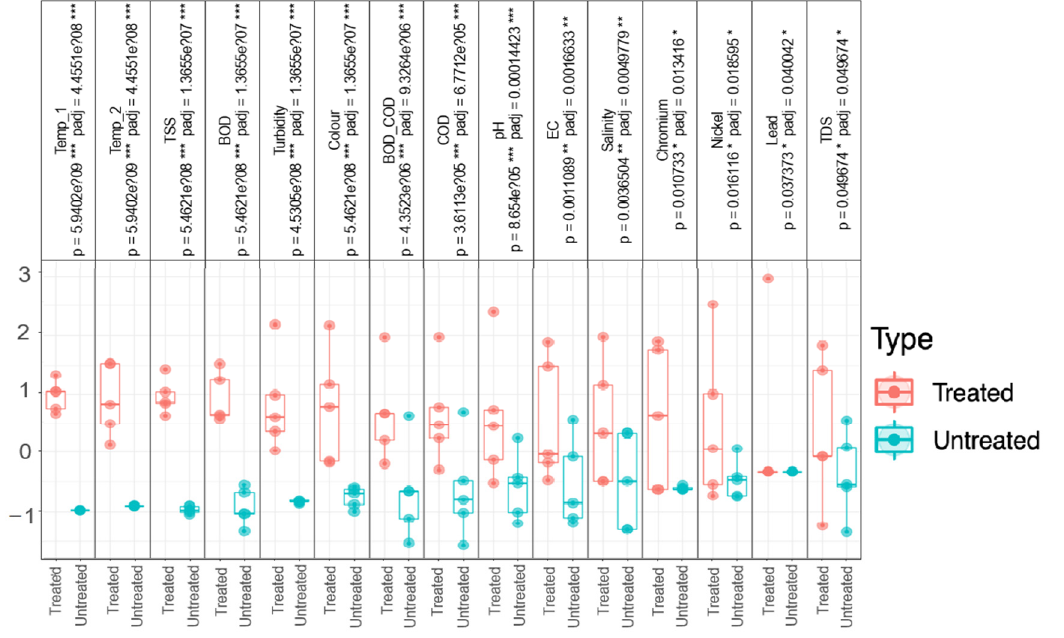
Figure 1. Box-plot graph showing the results of a Kruskal–Wallis statistical test to determine which of the water quality parameters (TSS, BOD, Turbidity, Colour, BOD_COD, COD, pH, EC, Salinity, Chromium, Nickel, Lead, TDS) were discriminating between the Untreated wastewater (in blue) and the Treated biotreated hospital wastewater (in red) on the x -axis and the autoscaled abundance on the y -axis. The statistical significance values are denoted within the box plots with symbol * and are indicated by p < 0.05 *, p < 0.01 **, p < 0.001 ***, p < 0.0001 ****.